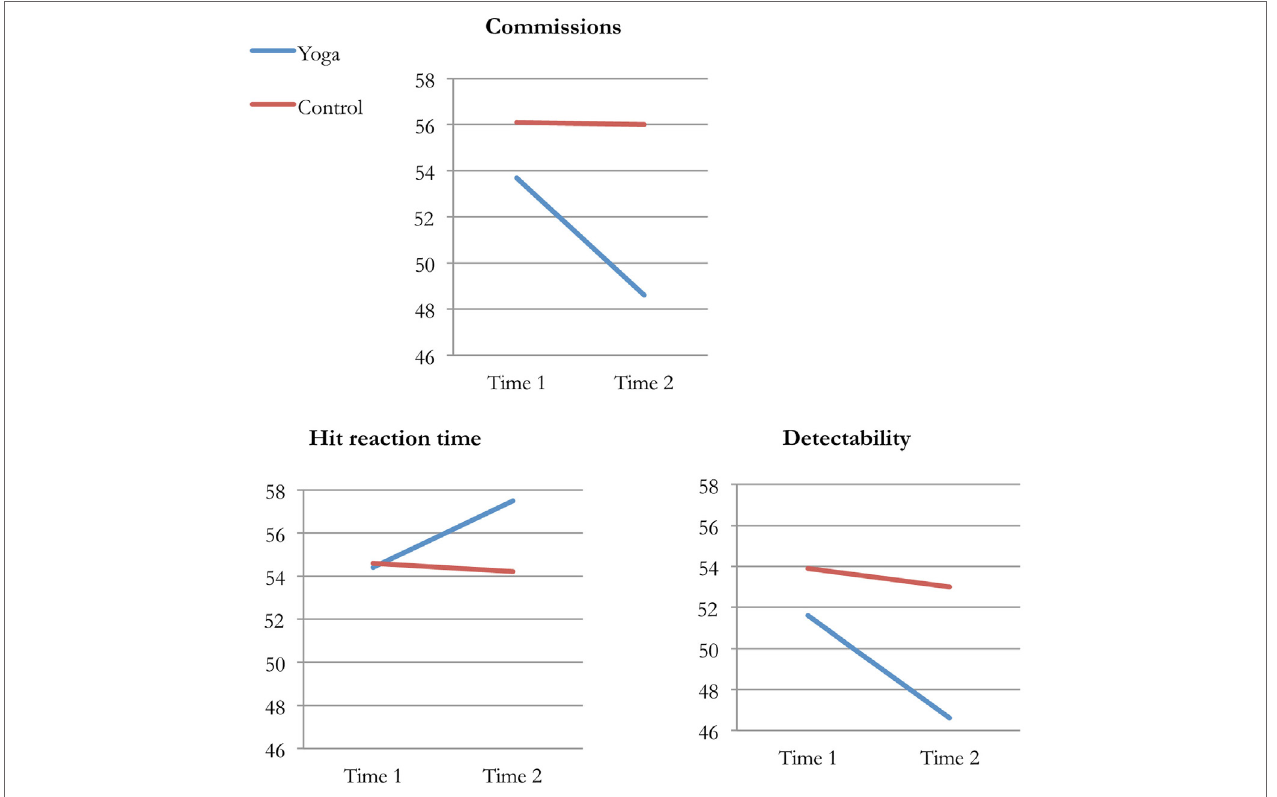
FigUre 4 | Average performance ( T -scores) on commissions, hit reaction time, and detectability in the yoga and control group at Time 1 and Time